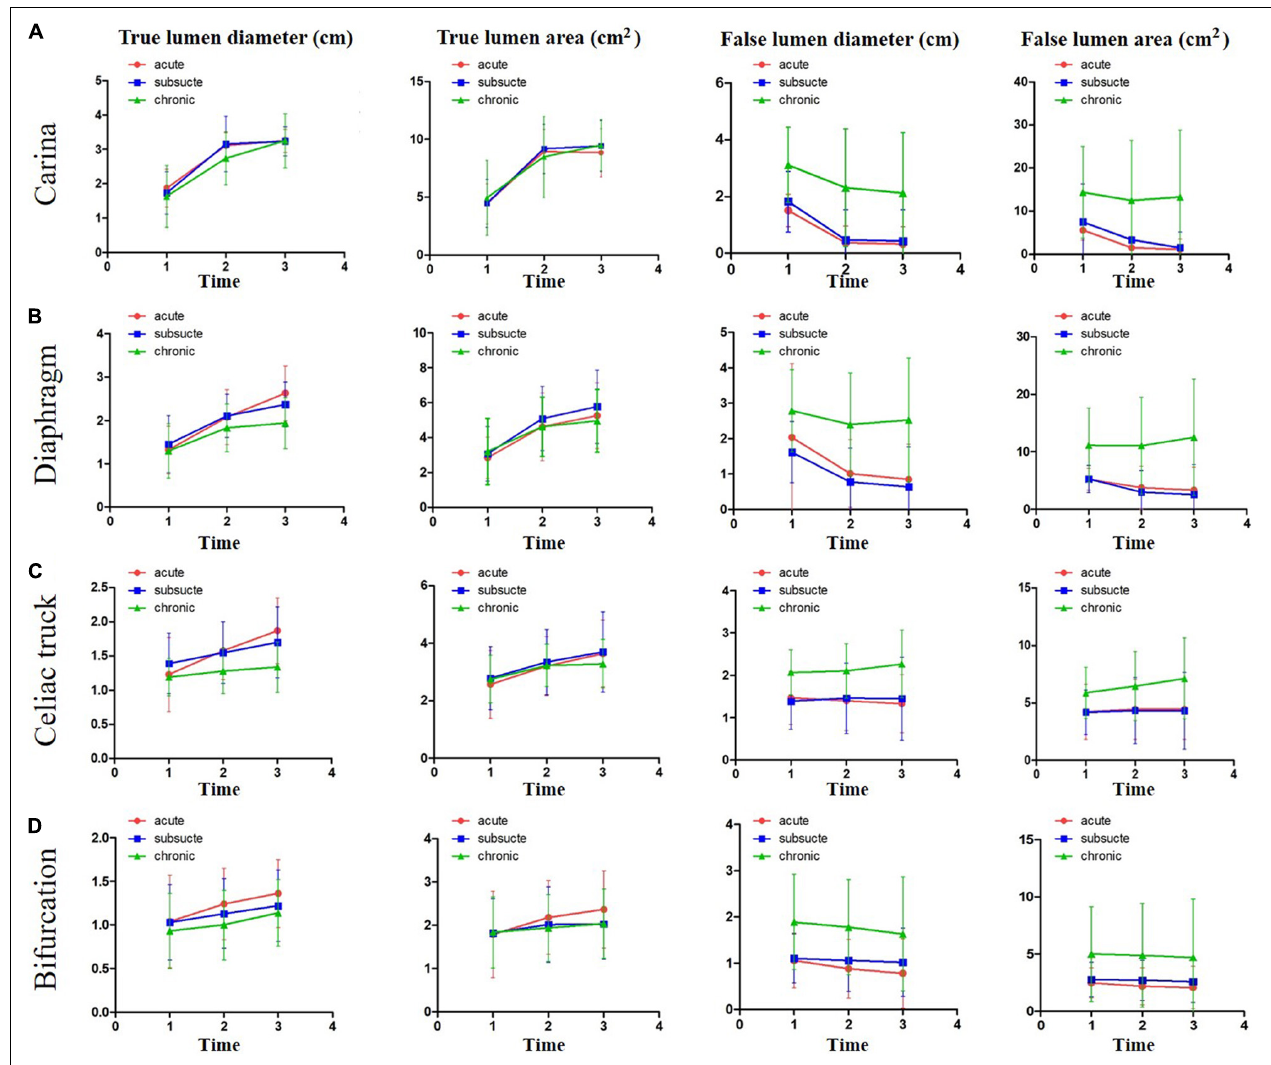
FIGURE 3 | The dimensional changes of TL and FL over a 5-year follow-up period. The changes of TL and FL dimensions over time were plotted for acute, subacute, and chronic aortic dissections after TEVAR at the levels of tracheal carina (A) , diaphragm (B) , celiac trunk (C) , and abdominal aorta bifurcation (D) . Time 1, before operation; Time 2, 2 years after operation; and Time 3, 5 years after operation. TL, true lumen; FL, false